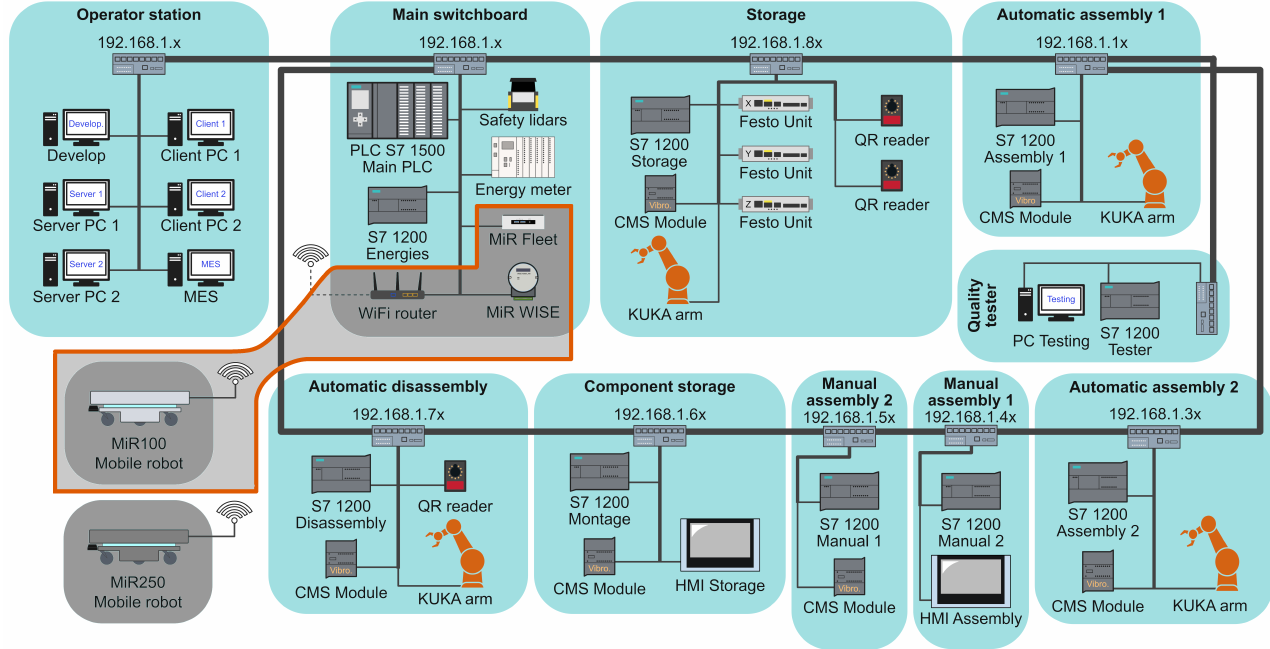
Figure 7. SmartFactory network diagram. The highlighted gray part is the solution